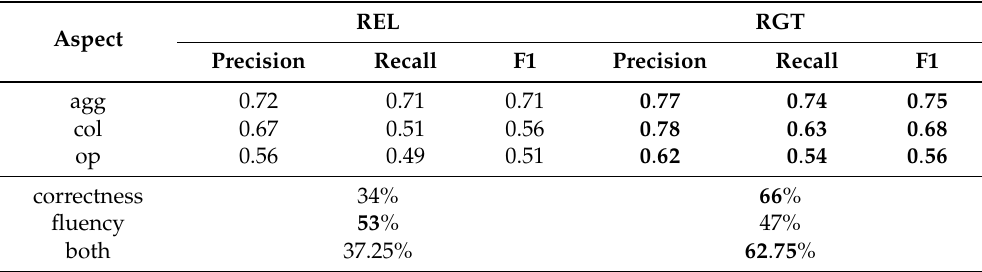
Table 8. Human evaluation for our model (RGT) and transformer with relative position (REL). Bold means the best